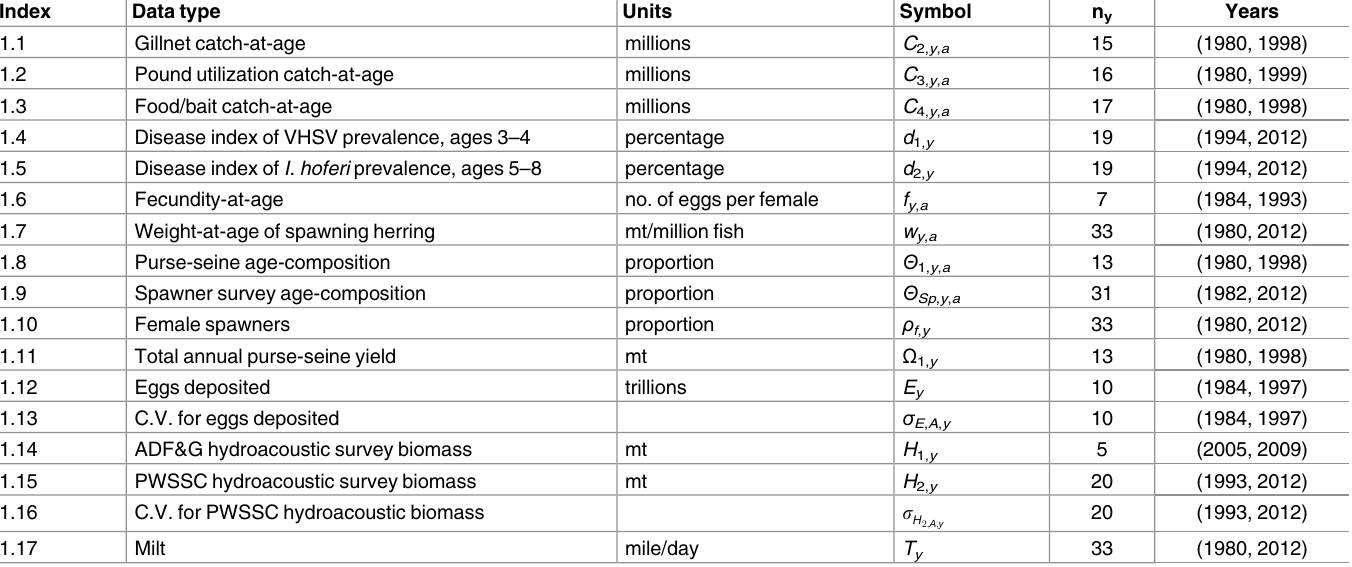
Table 1. Time series used in the BayesianASA model. The first column lists the index numberused in the text, the next columns list the data type and units,